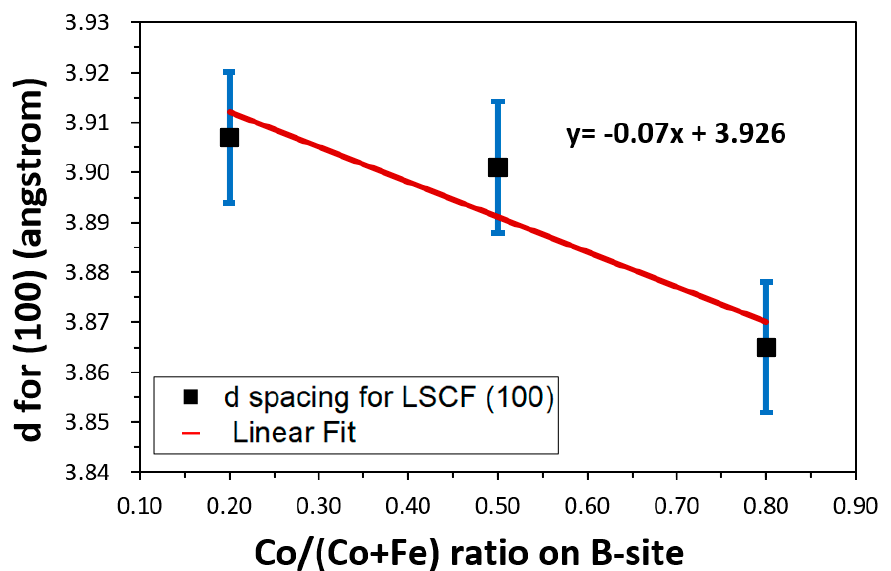
Figure 5. The d-spacing against the ratio of Co/(Co + Fe) in the